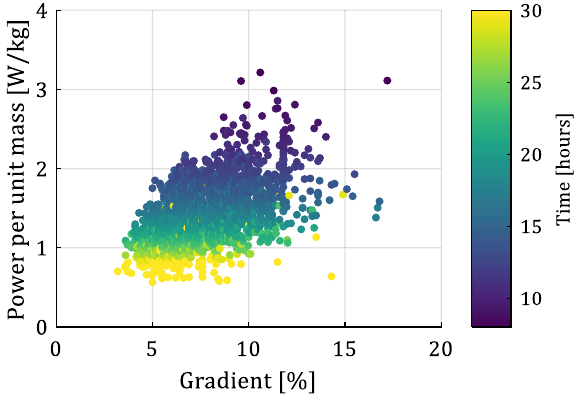
Figure 3. Estimated power per unit body mass as a function of the gradient, with the color of each datapoint indicating the total time (colorbar), illustrating that cyclists who can output high power per unit mass preferentially select a steep gradient.